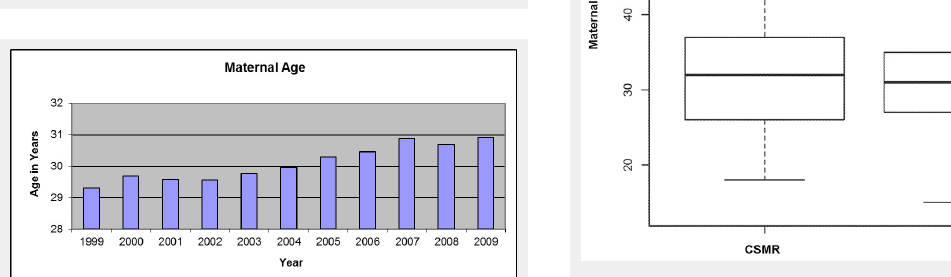
A: Temporal change of the caesarean section on maternal request (CSMR) rate in the observation period of time. The mean CSMR was 1.45% and a significant increase was detected (p = 0.008). B: Caesarean section on maternal request in different Robson groups in the observation period of time. Groups 2 and 4 (woman with single cephalic pregnancy ≥37 weeks gestation with induced labour or CS before labour) displayed the highest CSMR rates (7.6% and 4.8%, respectively).